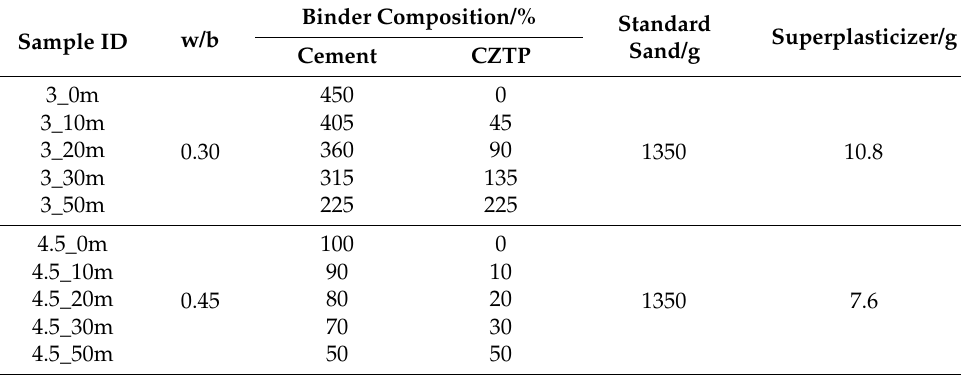
Table 3. Mix proportions of